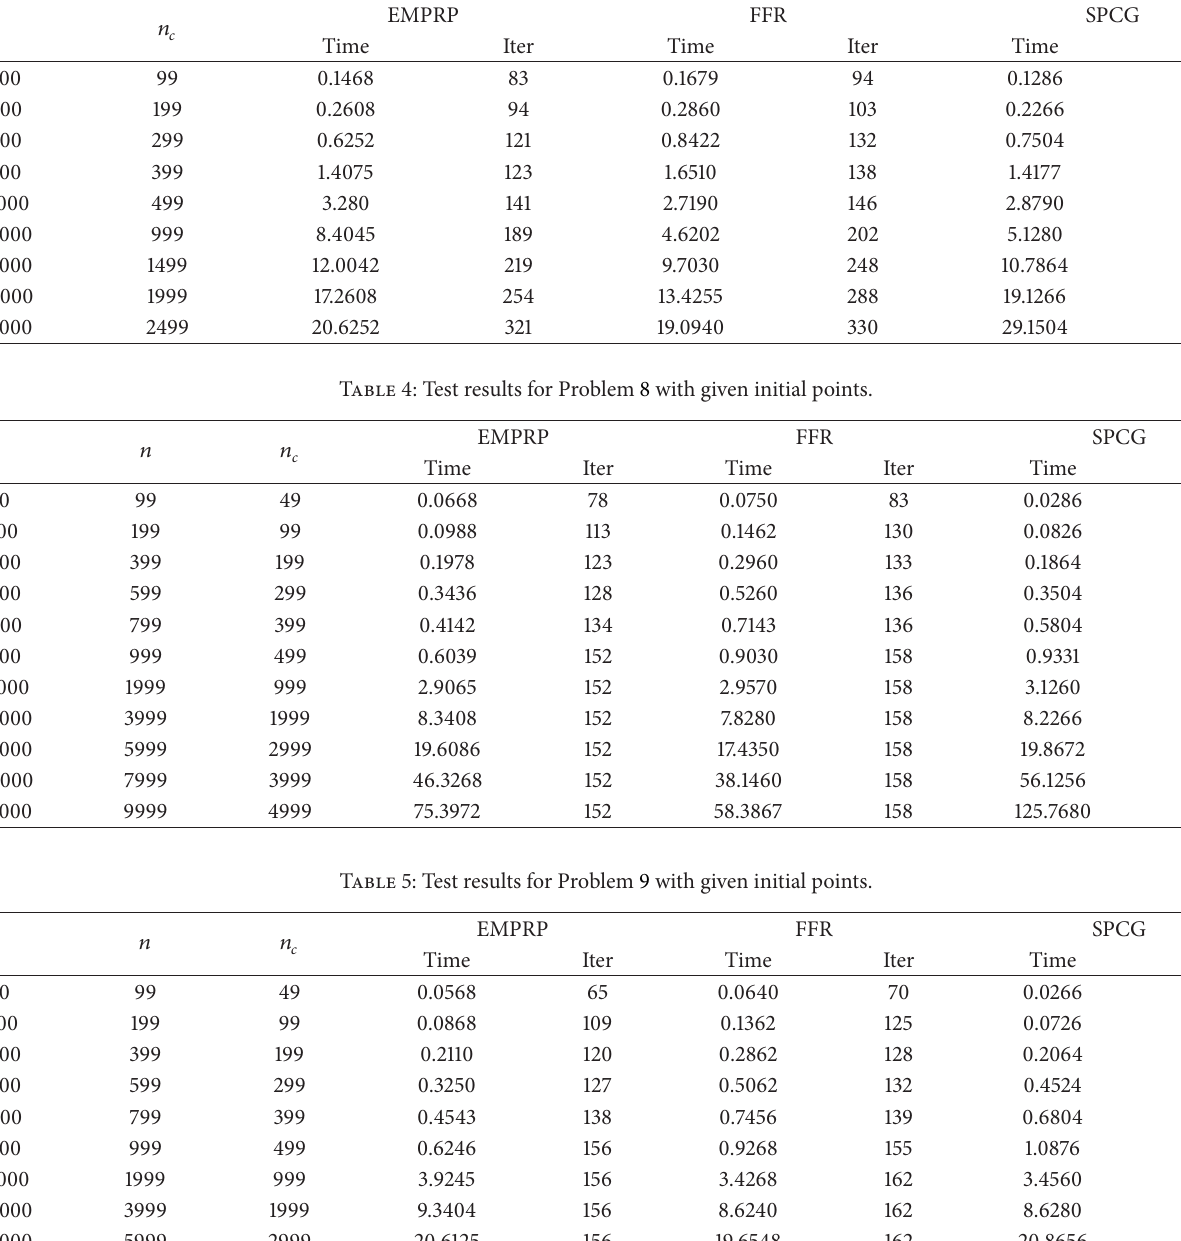
Table 3: Test results for Problem 7 with given initial points.